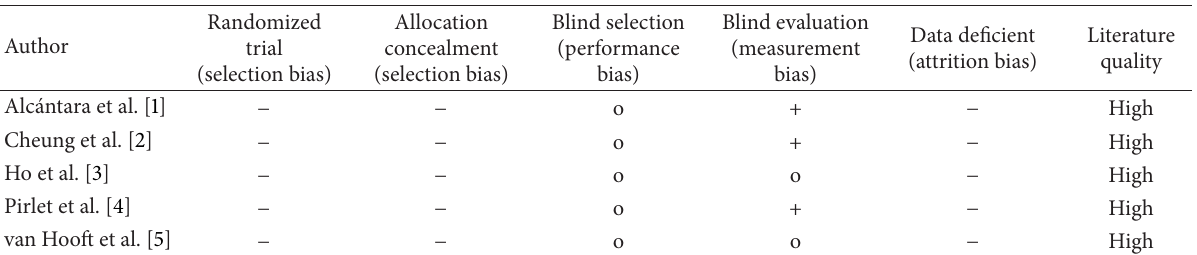
Table 1: Bias risk profile and score of Jadad scale. (a) Bias risk profile